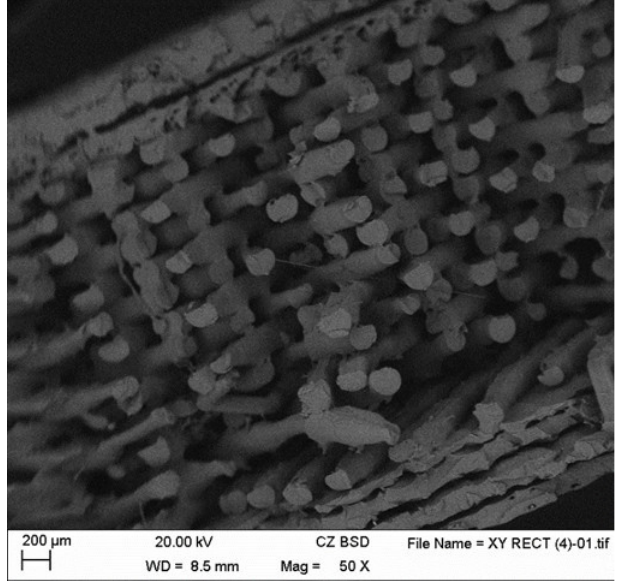
Figure 11. Rectilinear